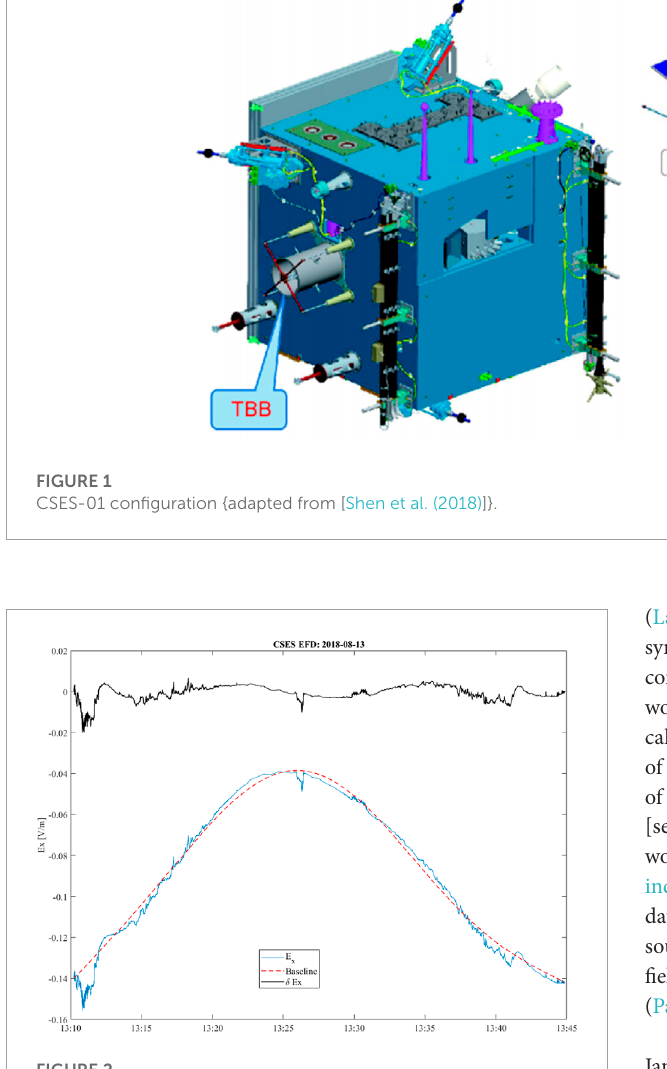
FIGURE 2 Application of the FIF technique to electric field data (expressed in V/m) from the CSES-01 satellite along an example orbit on 13 Aug 2018. The blue line represents the real signal, the red dashed line is the baseline, while fluctuations are shown in